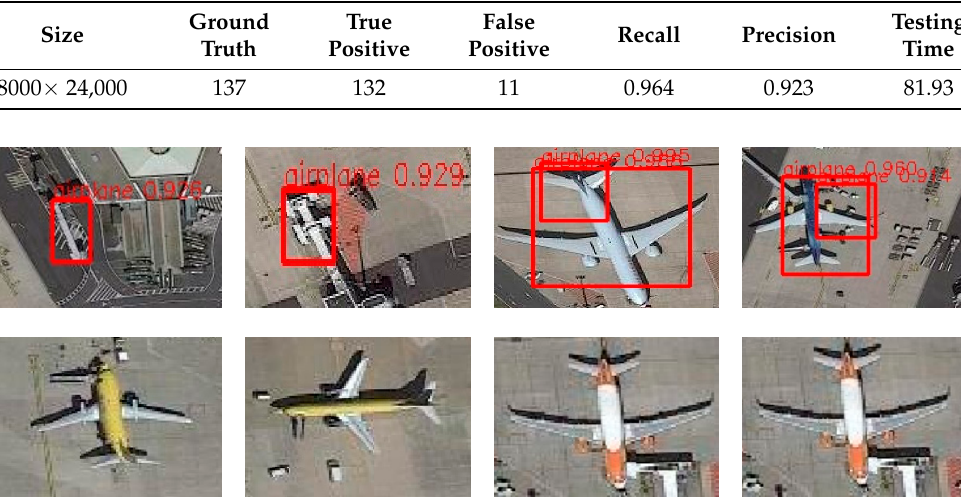
Figure 11. Detection results of our method in large range HRS imagery.